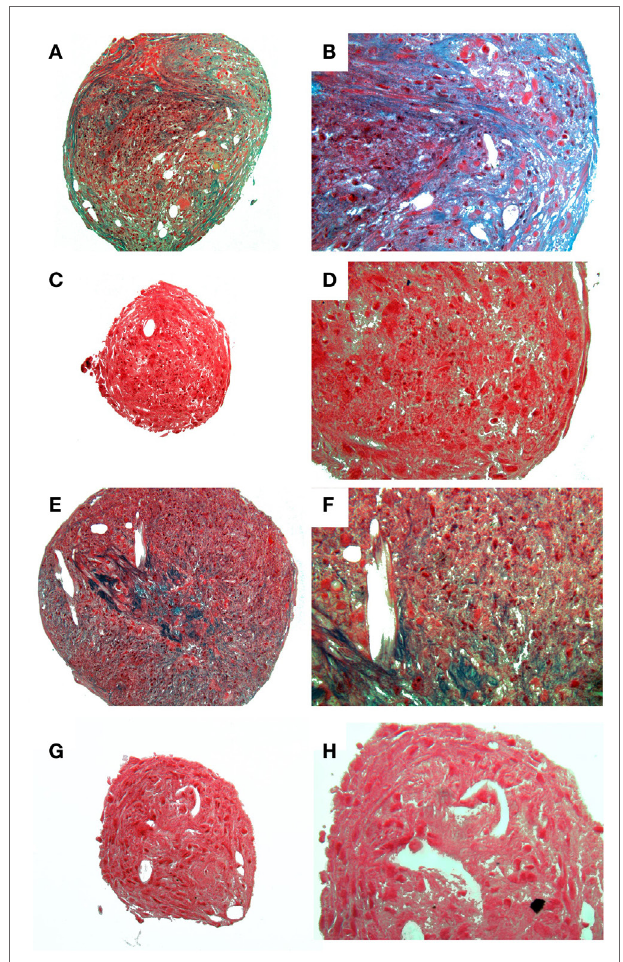
FigUre 4 | histological images showing chondrogenic differentiation. Adipose tissue (a–D) or bone marrow (e–F) at two magnifications stained for glycosaminoglycans with Alcian Blue. Control aMSCs [ (a) 4 × ; (B) 20 × ] or differentiated aMSCs in chondrogenic medium [ (c) 4 × ; (D) 20 × ]. Control bMSCs [ (e) 4 × ; (F) 20 × ] or differentiated bMSCs in chondrogenic medium [ (g) 4 × ; (h) 20 ×